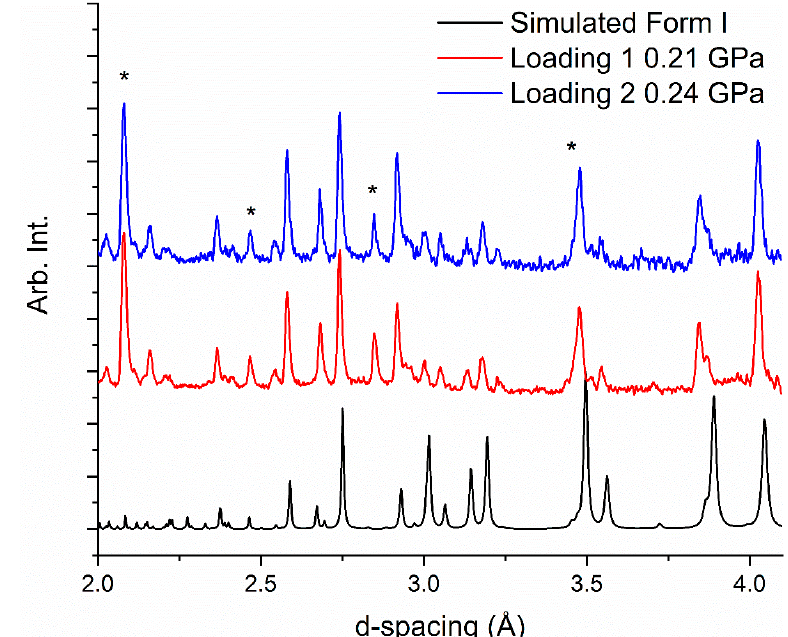
Figure 2. Neutron diffraction patterns of caprolactam- d 10 (in d-spacing) from samples recrystallized from ethanol- d 6 (top) and ethyl acetate (middle) together with a simulated pattern from the X-ray data from Winkler and Dunitz (bottom) [24]. The asterisks indicate the presence of alumina and lead that are part of the Paris-Edinburgh cell set-up. There is a peak of alumina that overlaps with a sample peak at 3.5 Å.